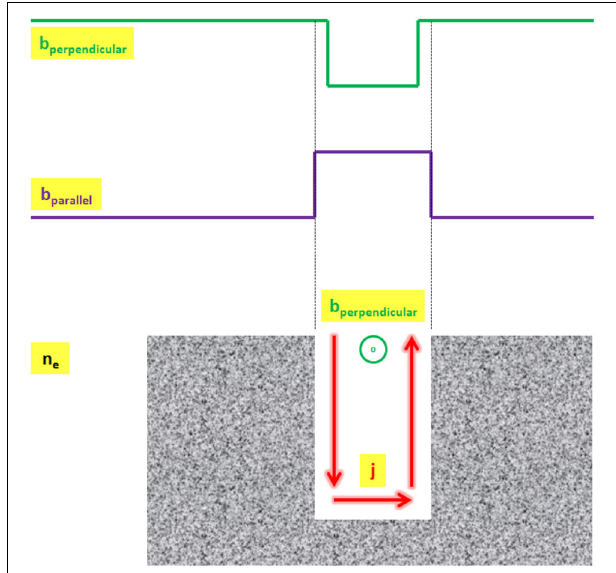
FIGURE 5 | Schematic illustration of magnetic signatures accompanying a local plasma depletion. The diamagnetic effect causes an enhancement of the magnetic field strength (b parallel ) at the location of plasma depletion. Alfvén waves carried by field-aligned currents within the bubble walls cause collocated deflections of the transverse magnetic components (b perpendicular